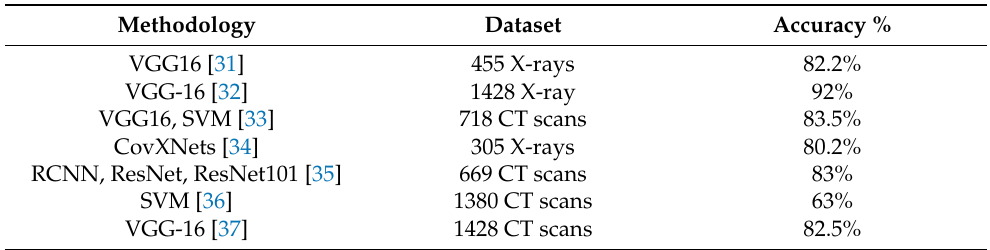
Table 2. Comparative analysis of the existing classification models for pulmonary diseases using lung scans and